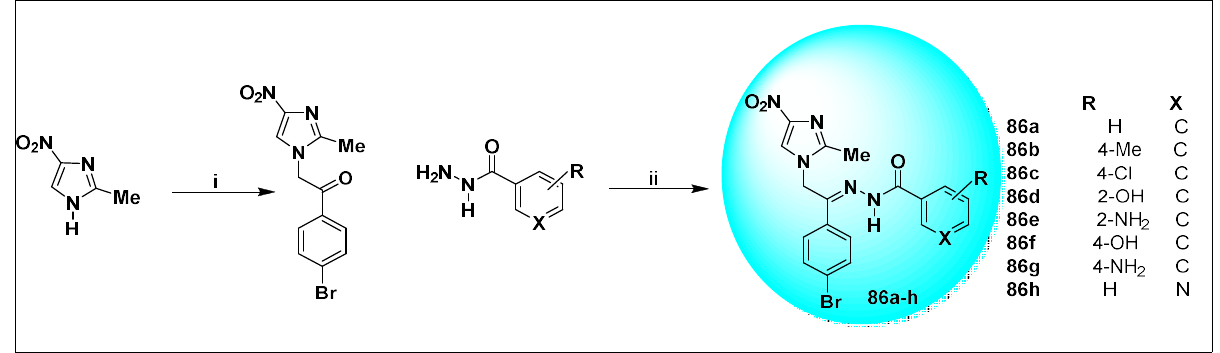
Scheme 26. Synthesis of 4-nitroimidazole derivatives as antibacterial, EGFR-based anticancer agents. Reagents and conditions: ( i ) 2-bromo-1-(4-bromophenyl)ethan-1-one, K 2 CO 3 , TBAB, MeCN (yield not reported); ( ii ) Ni(NO 3 ) 2 , ethanol, rt, 54–88%.